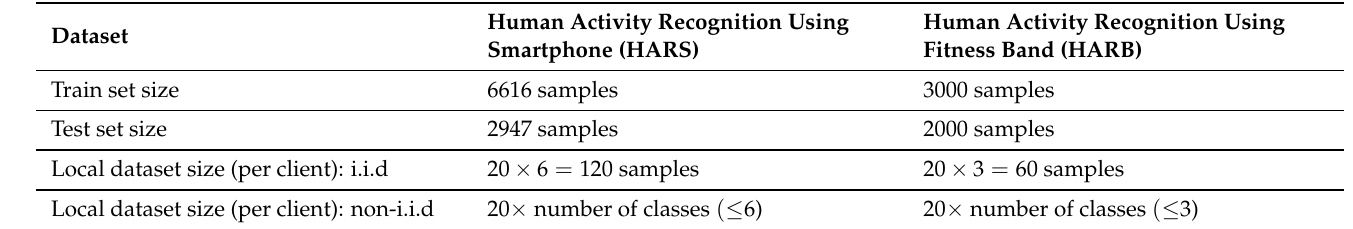
Table 1. HARB and HARS datasets sizes.